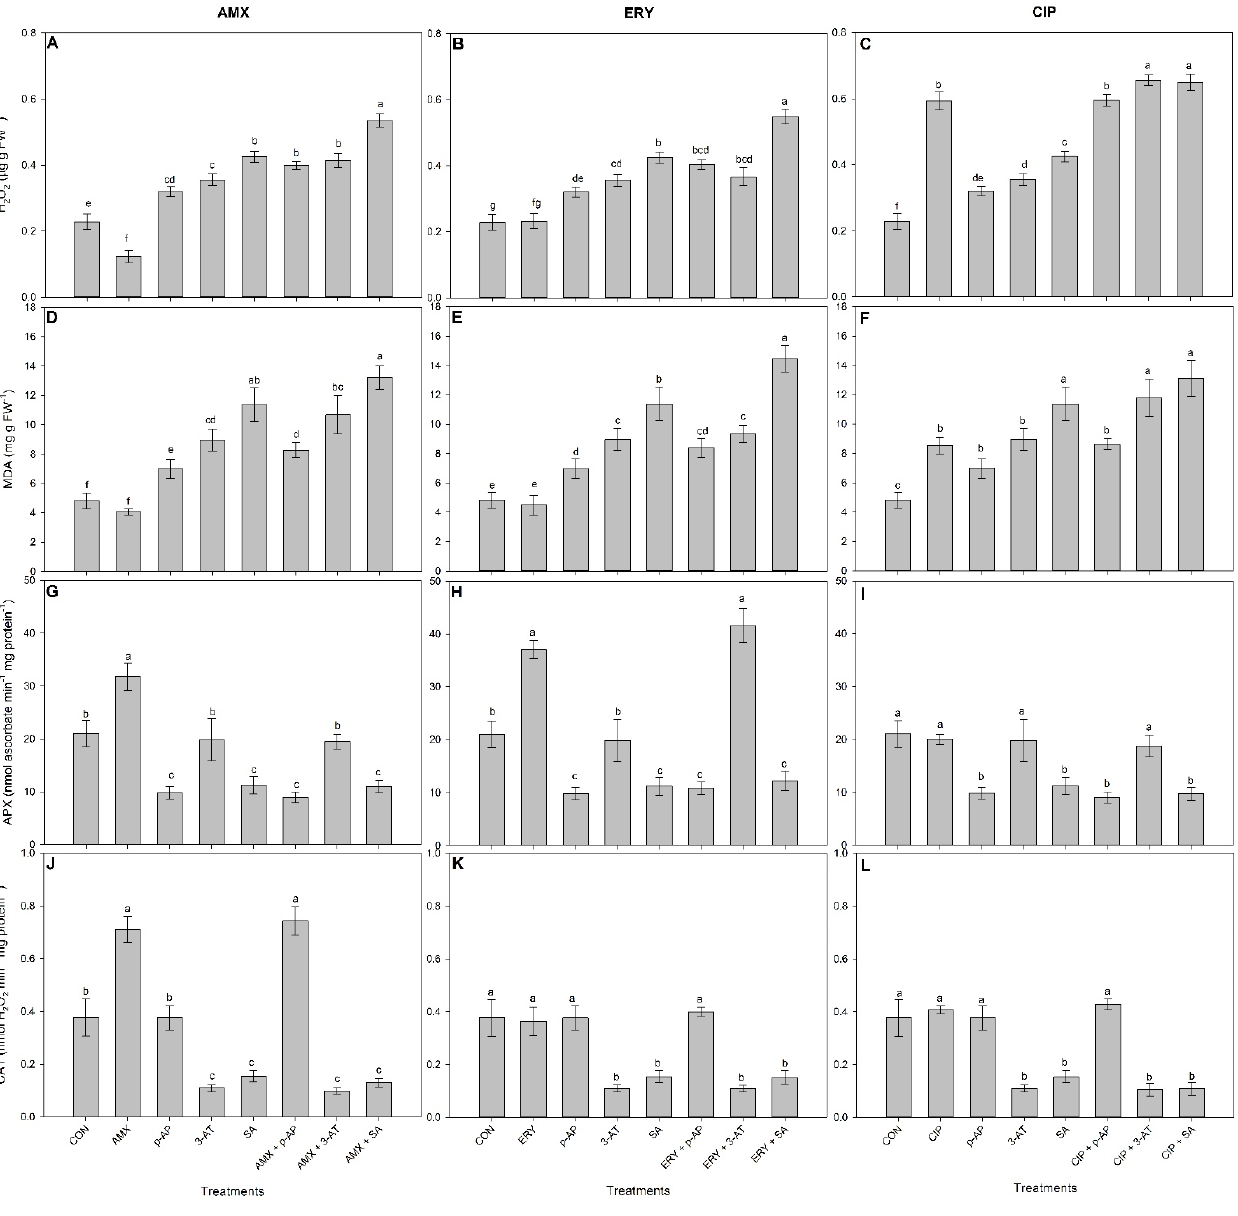
Figure 3. Hydrogen peroxide (H 2 O 2 ; A – C ) and malondialdehyde (MDA; D – F ) concentrations and ascorbate peroxidase (APX; G – I ) and catalase (CAT; J – L ) activities in L. minor plants exposed to isolated or combined concentrations of antibiotics and antioxidant-enzyme inhibitors for seven days. Bars represent the means ± SD of four replicates. Different letters indicate significant differences ( p > 0.05) using the post hoc Tukey test. CON = control; AMX = 2 µg amoxicillin L − 1 ; ERY = 1.7 µg erythromycin L − 1 ; CIP = 1.05 mg ciprofloxacin L − 1 ; p -AI = 5 mM p -aminophenol; 3-AT = 200 mM 3-amino,1,2,4-triazole; and SA = 1000 µM salicylic acid.